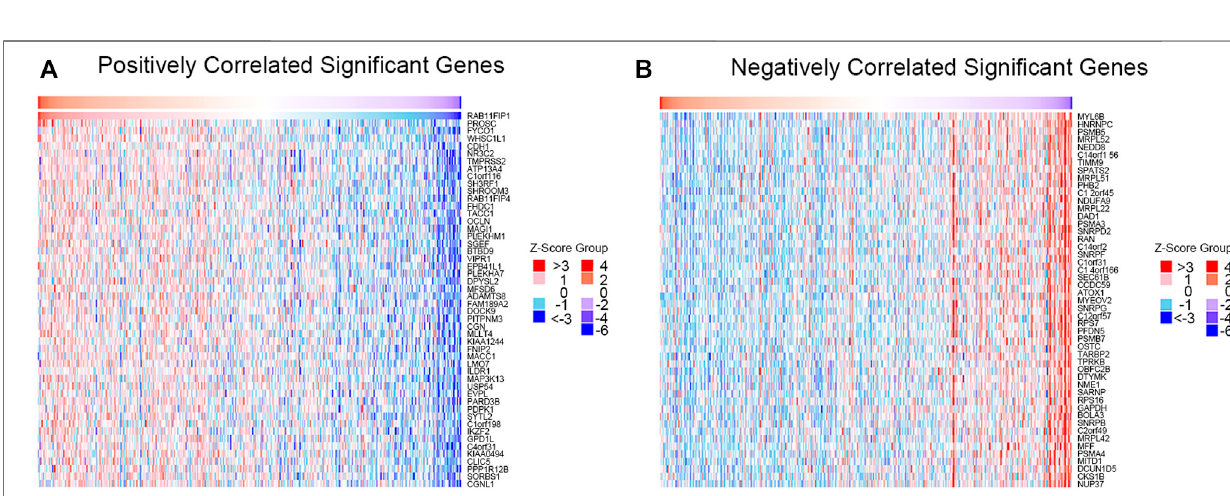
Frontiers in Genetics |